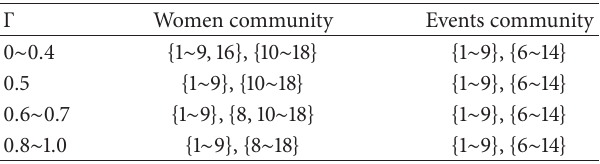
Table 5: The result of BELPA algorithm starting from women set with 0.1 as the step length of parameter 𝛾